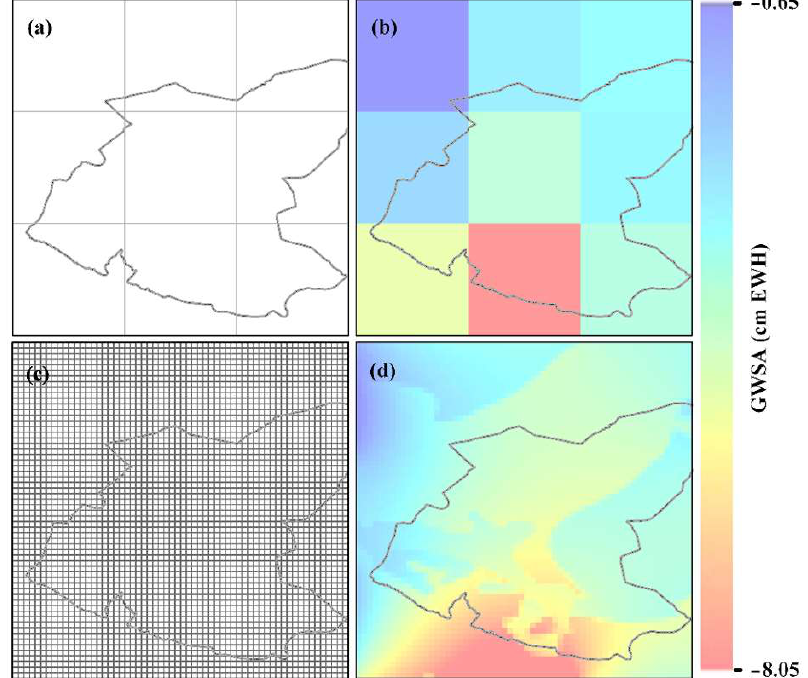
Figure 6. Comparison of groundwater storage changes before and after the downscaling in December 2019. ( a , c ) The 1° and 0.05° mesh grid blocks, respectively; ( b , d ) the spatial distribution of GWSA before and after downscaling.